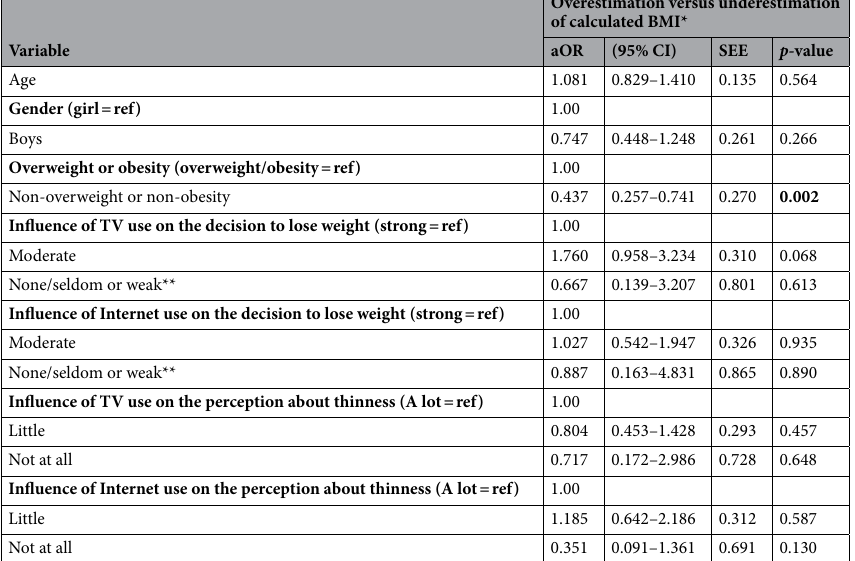
Table 5. Logistic regression analysis, adjusted for age, for selected variables related to underestimation or overestimation of the calculated BMI among Kuwaiti adolescents. *Overestimation was used as a reference category. aOR adjusted odds ratio, CI confidence interval, ref reference category, SEE standard error. **Categories were combined due to redundancy. Significant values are in